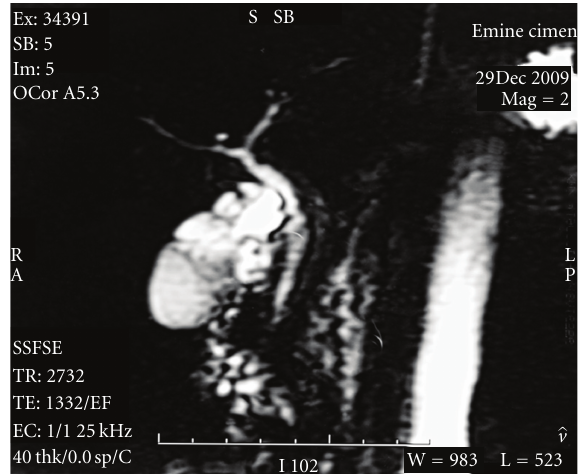
Figure 2: Grapelike cluster of the gallbladder in MRCP.